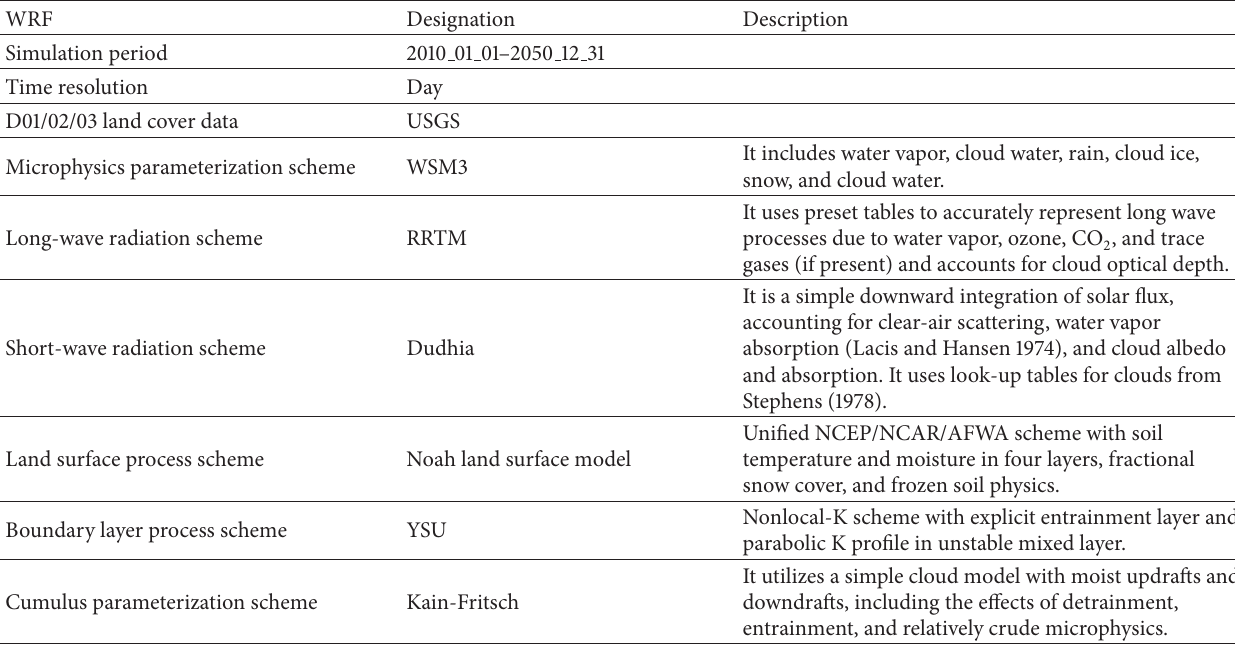
Table 1: Design of WRF model and relative description.